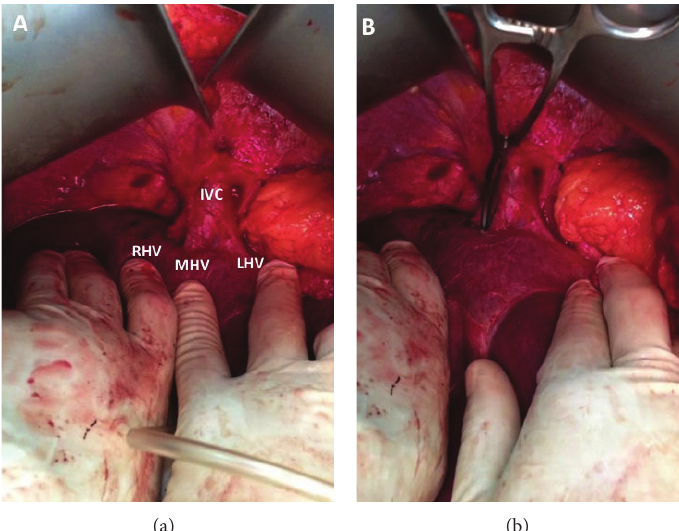
Figure 4: The hepatocaval junction is exposed in (a), allowing dissection of the space between MHV and RHV with a curved vascular clamp in (b).